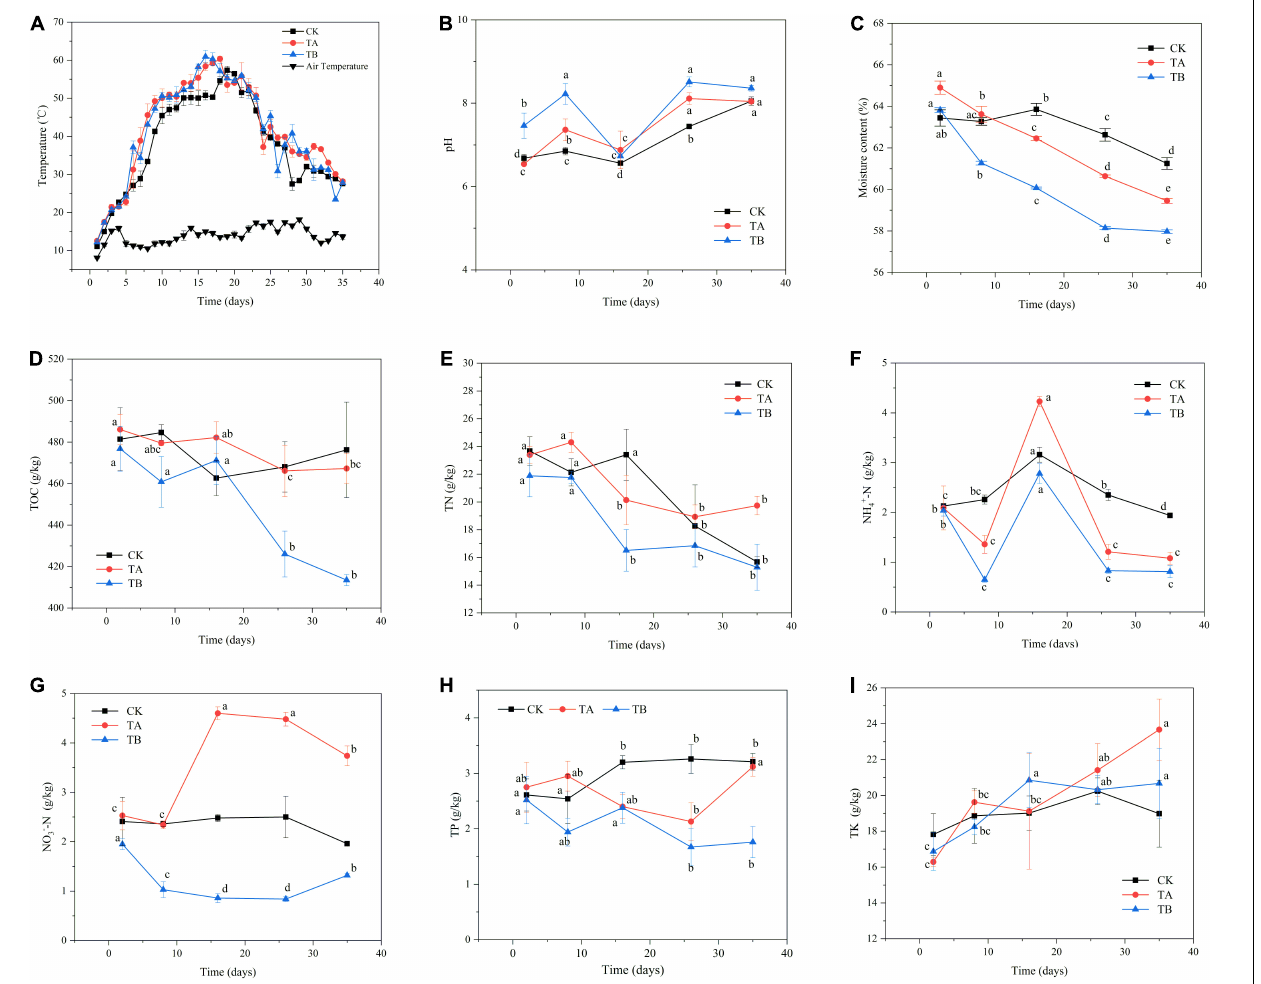
FIGURE 1 | The changes in physicochemical properties during 35 days of aerobic composting with three treatments. (A) temperature, (B) pH, (C) moisture content, (D) total organic carbon, (E) total nitrogen, (F) nitrate nitrogen, (G) ammonium nitrogen, (H) total phosphorus, (I) total potassium. CK: without any treatment; TA-microbiological inoculum (microbiological inoculum volume/pile quality was 1%), TB-microbiological inoculum (1%) combined with 10% coconut shell